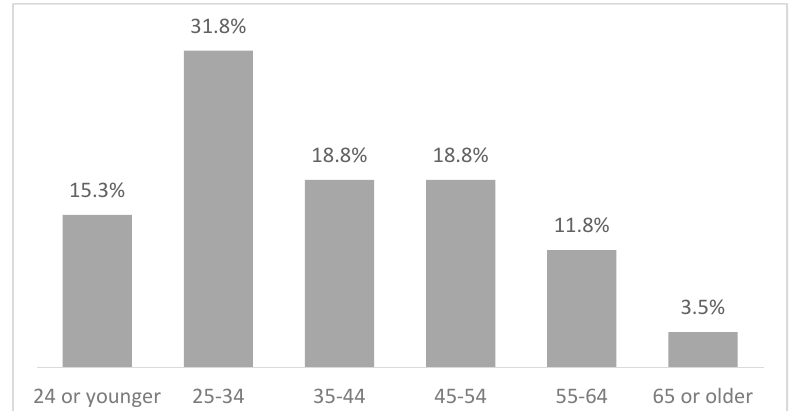
Figure 1. Age distribution respondents.